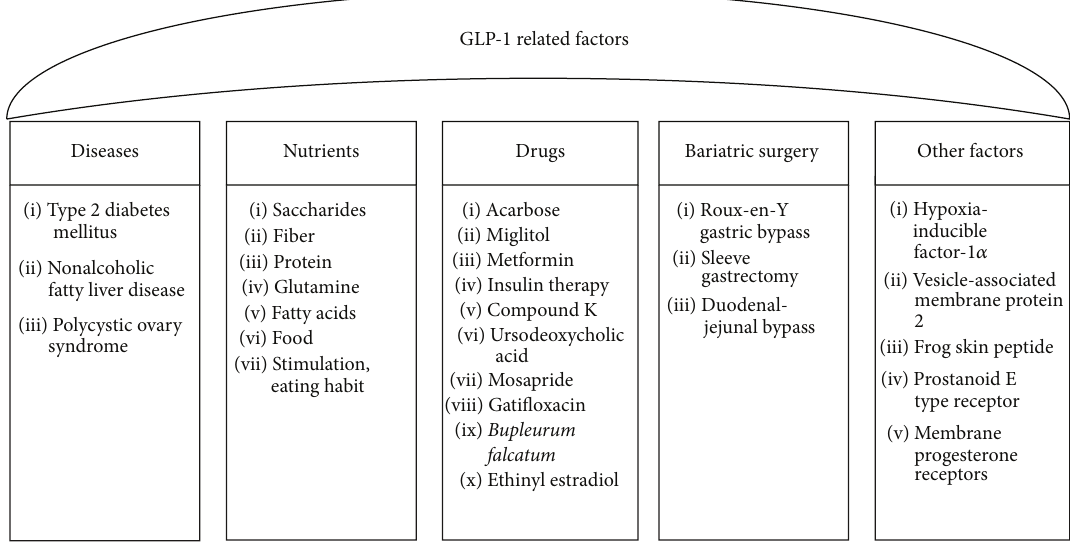
Figure 1: Levels of glucagon-like peptide-1 related